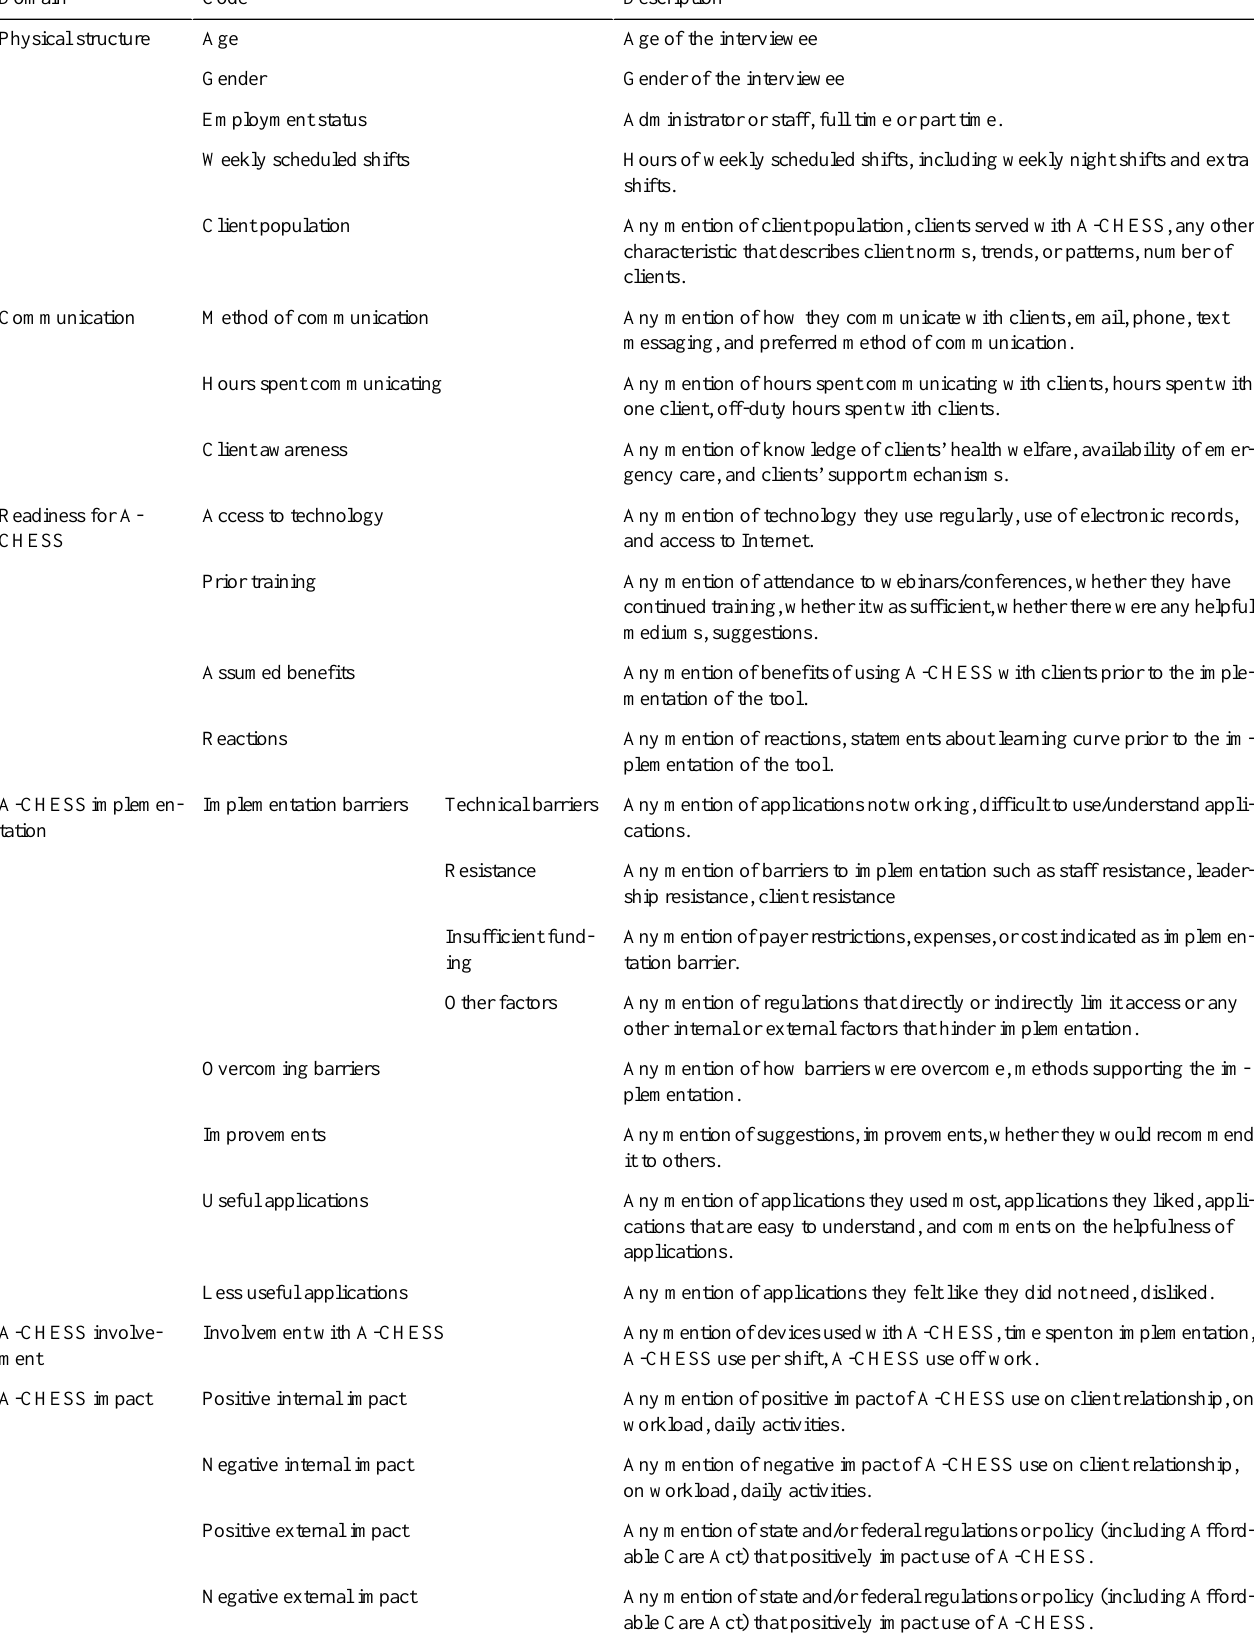
Table 1. A-CHESS coding scheme.